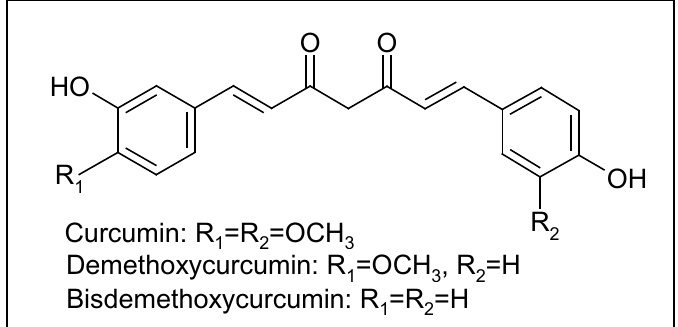
Figure 8. Curcuminoids, polyphenolic constituents of turmeric, the dried ground rhizome of Curcuma longa